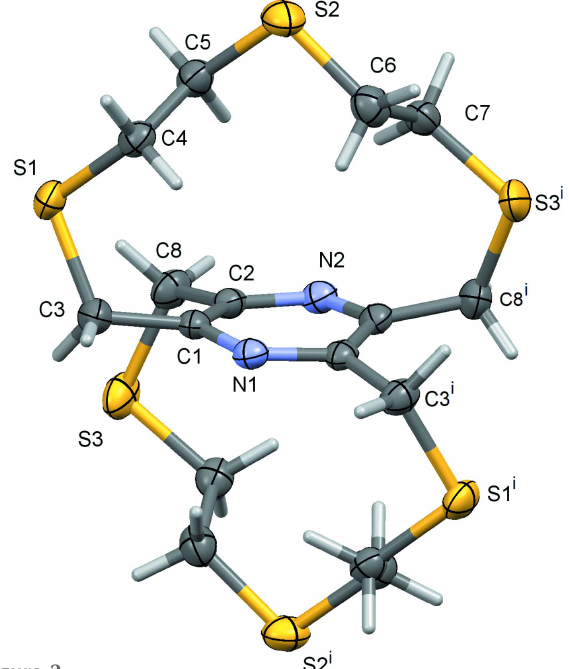
Figure 2 A view of the molecular structure of compound II , the regioisomer p -bis L1, withatom labelling forthe asymmetric unit[symmetry code:(i) (cid:4) x +2, y , (cid:4) z + 3 ]. Displacement ellipsoids are drawn at the 50% probability level. 2